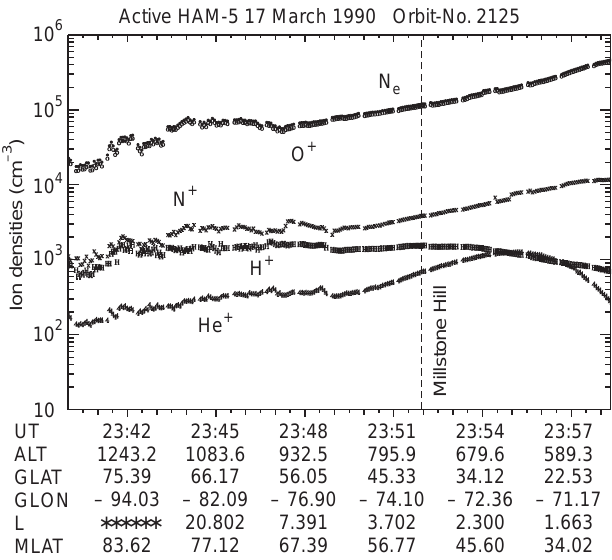
Fig. 2. Ion density measurements of the HAM-5 probe onboard the Active satellite along the orbit 2125 path. This passed the Millstone Hill station within a horizontal distance of the path projection to the Earth’s surface of 160 km just prior to the first storm onset during local sunset (23:52 UT) on 17 March 1990. See Fig. 3 for the direct comparison with the radar measurements